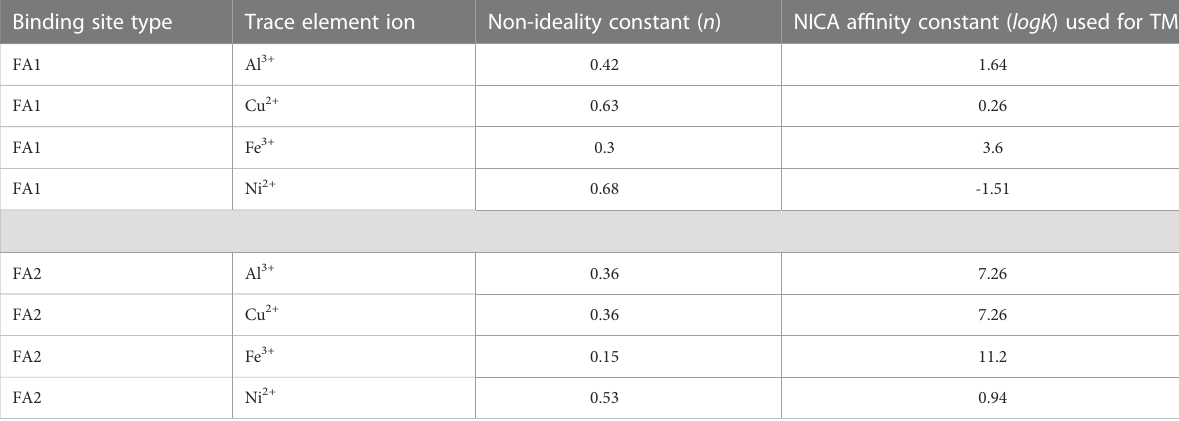
TABLE 3 NICA constants for Visual MENTIQ modeling in this study. Binding site